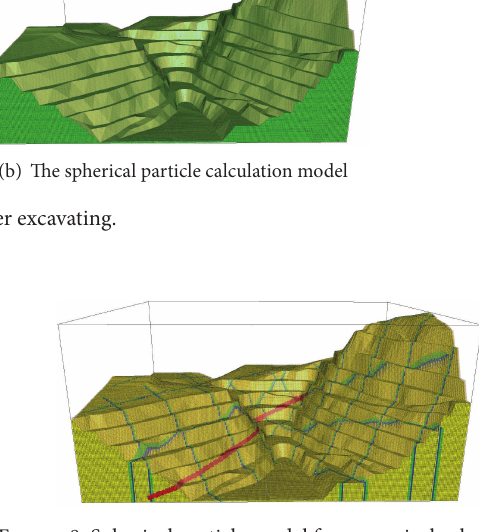
Figure 8: Spherical particle model for numerical